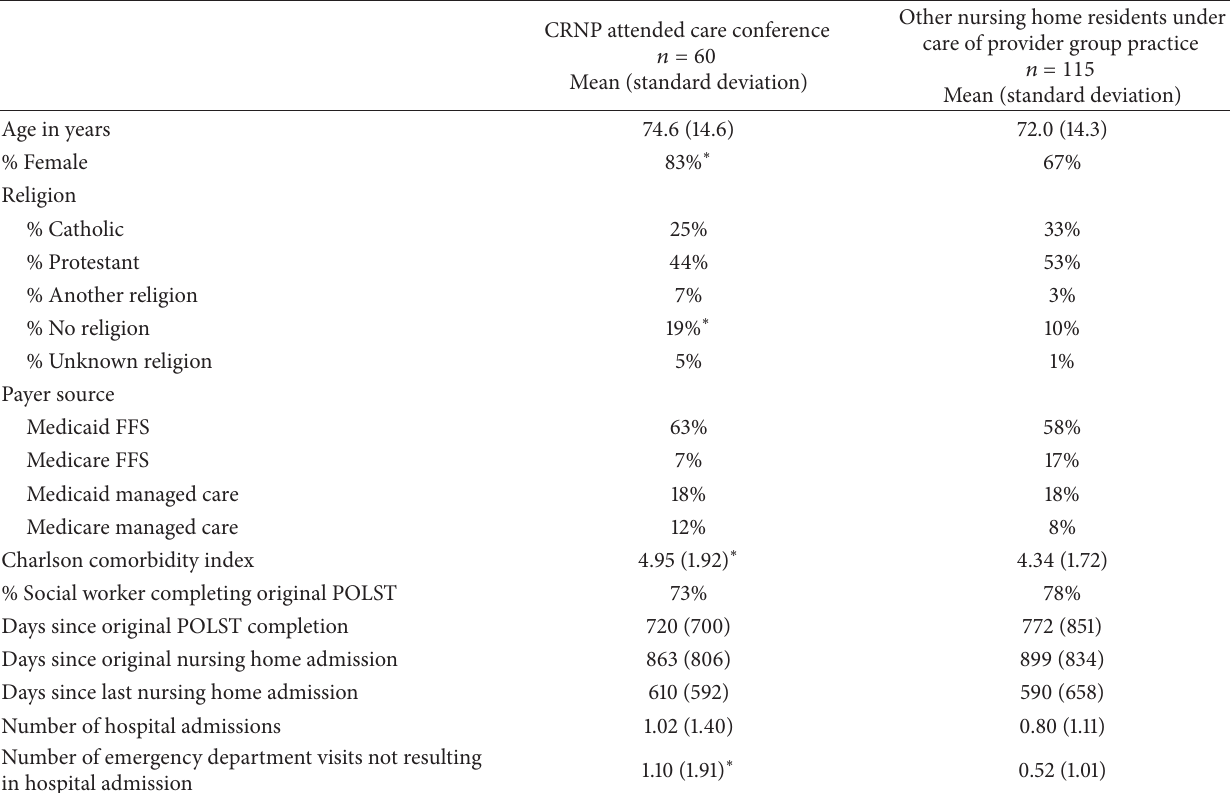
Table 1: Demographic and health care utilization characteristics of nursing home residents in provider group practice, by CRNP participation in care